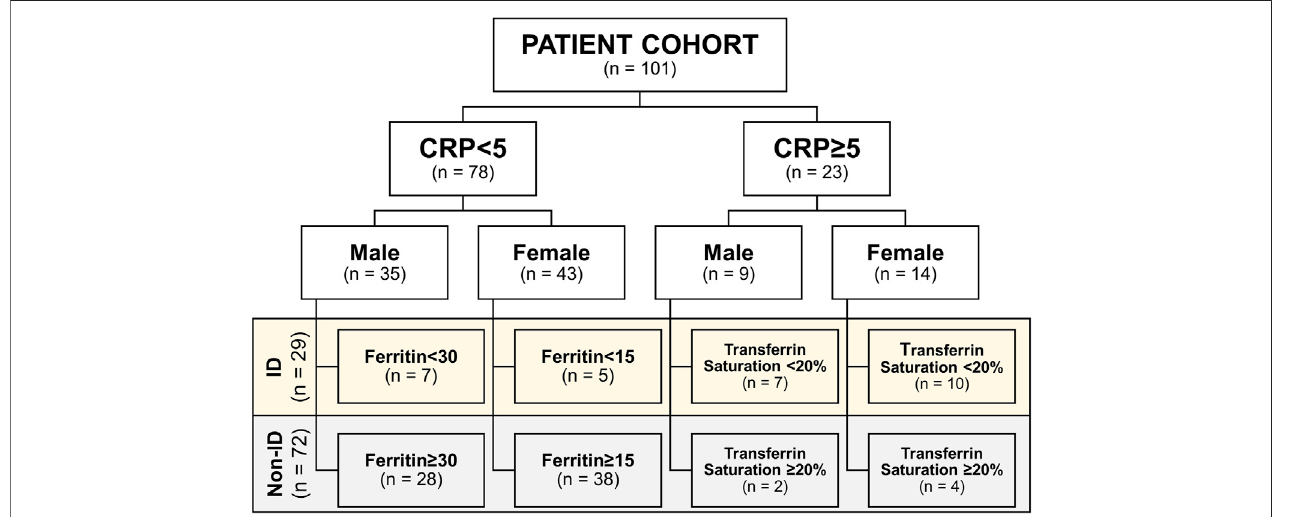
FIGURE 1 | Cohort subdivision in iron de fi ciency (ID) and non-ID groups according to criteria. CRP, C-reactive protein.